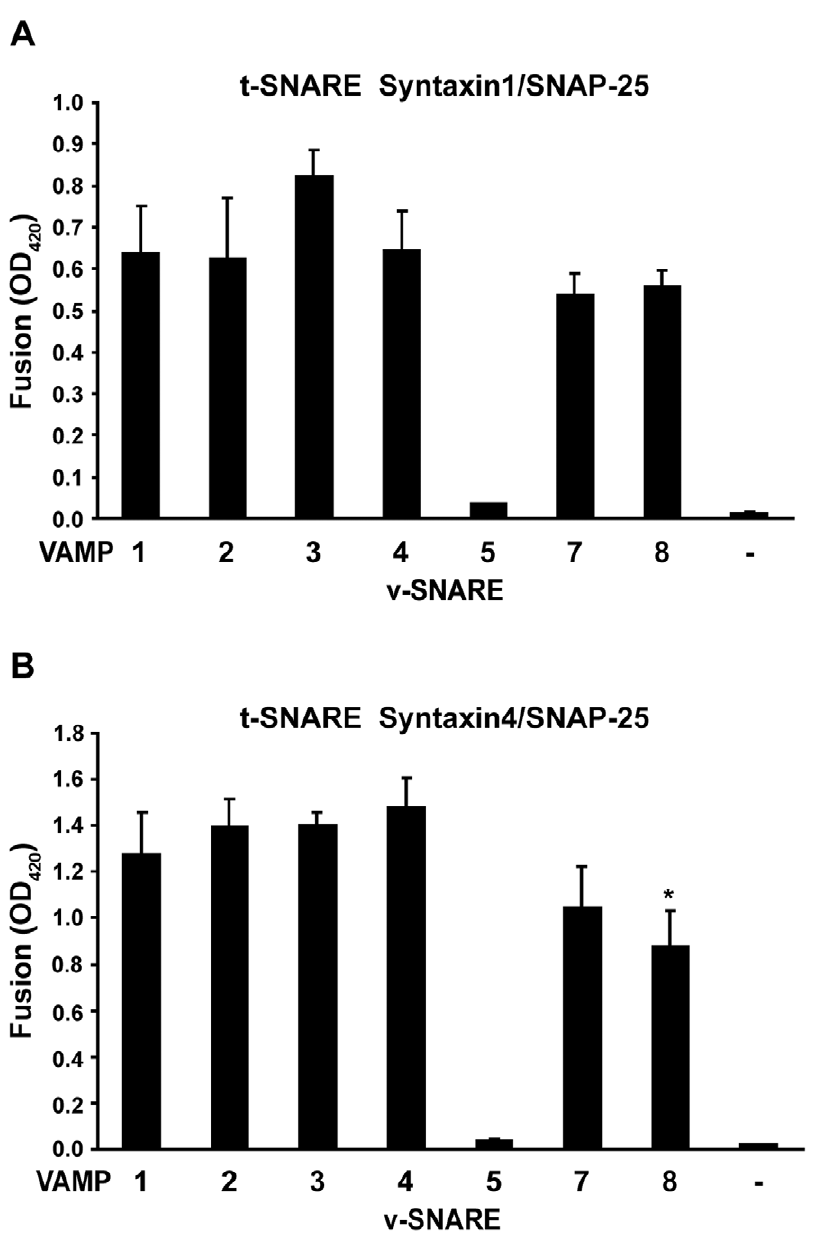
Figure 3. Cell fusion by VAMPs and plasma membrane t-SNAREs. 24 h after transfection, v-cells that expressed tTA and VAMPs 1, 2, 3, 4, 5, 7 or 8 were combined with t-cells that expressed TRE- LacZ and (A) syntaxin1/SNAP-25 or (B) syntaxin4/SNAP-25. After 24 h, cell fusion was quantified using the enzymatic cell fusion assay. Control cells (-VAMP) were cotransfected with the empty vector and the plasmid encoding tTA. Only baseline b - galactosidase activity was detected when the control cells were incubated with the t-cells. The flipped SNARE plasmids were transfected at the same concentration. Error bars represent standard deviation of three independent experiments. * P , 0.05 vs. VAMP1.